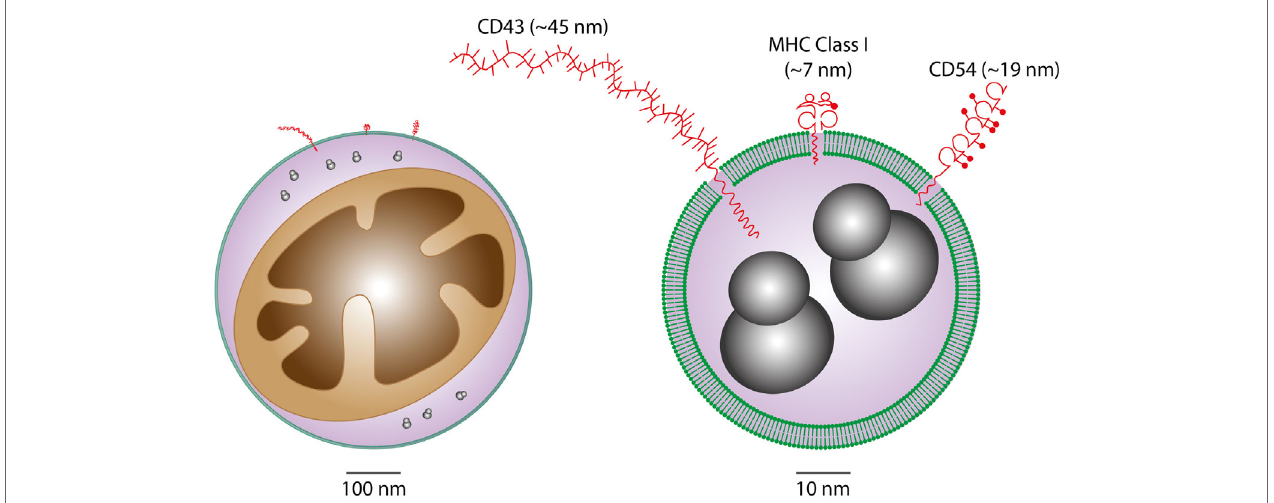
FiGUre 2 | Considerations of vesicular cargoes in relation to extracellular vesicle (EV) sizes. Schematic representations of Apo-EVs of ~500 nm (left) and 50 nm (right) are shown with delimiting lipid bilayer (green), a small mitochondrion (brown), ribosomes (gray), and examples of surface proteins all drawn approximately to scale. Note the significant potential impact of surface molecule size on total vesicle size in the case of small vesicles displaying relatively large surface molecules [measurement and representation of cell surface proteins adapted from Ref.